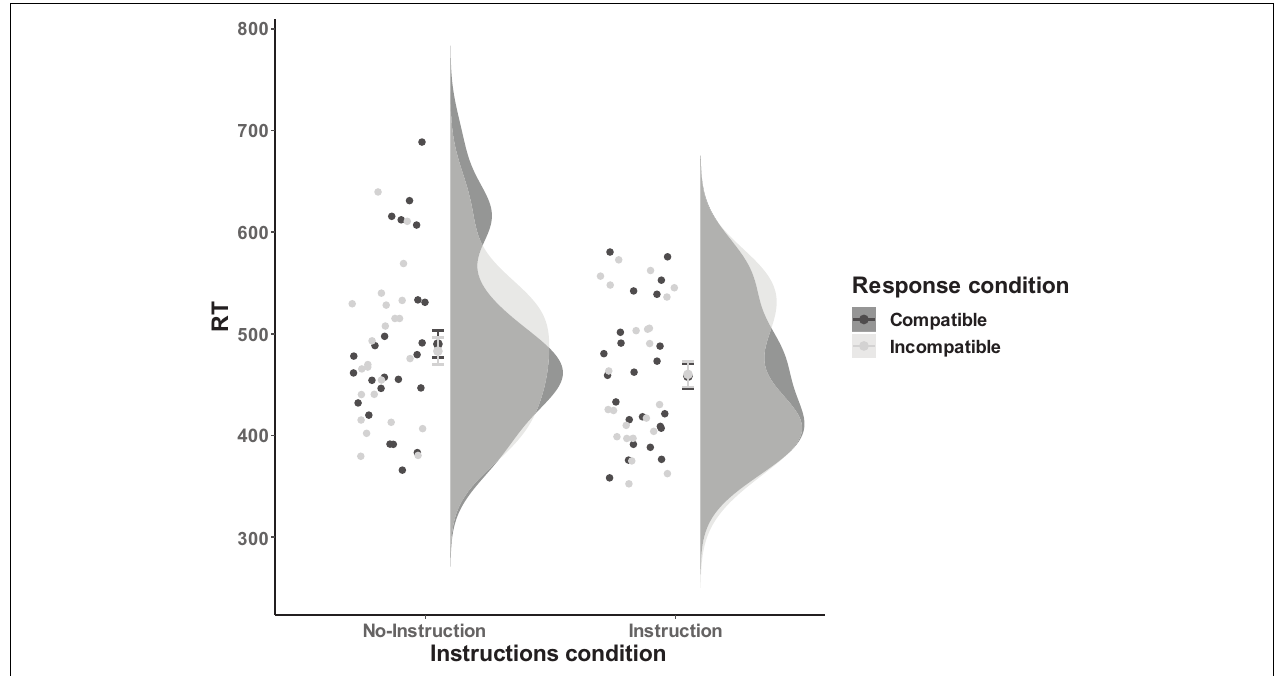
FIGURE 5 | The response performance distribution of all the individual data points for each condition in Experiment 2. The compatible and incompatible trials are defined depending on the Response-Outcome mapping in the acquisition phase. Error bars represent the 95% confidence intervals.